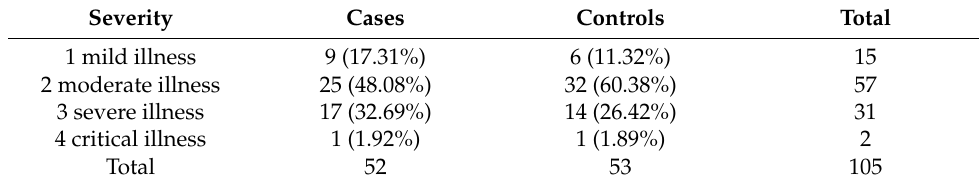
Table 5. Clinical course of